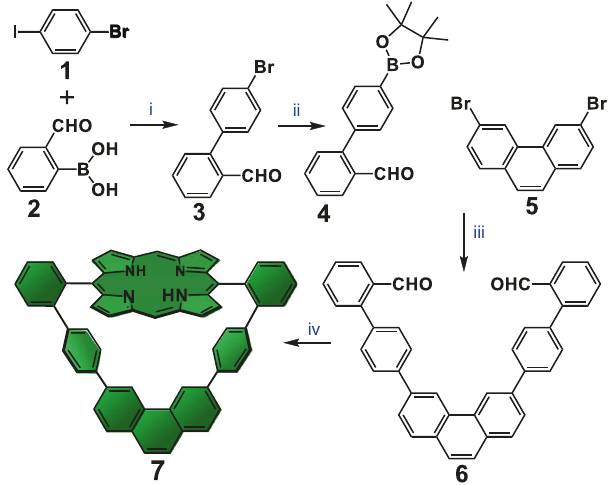
Fig. 1 Synthetic strategy for the preparation of macrocycle 7.